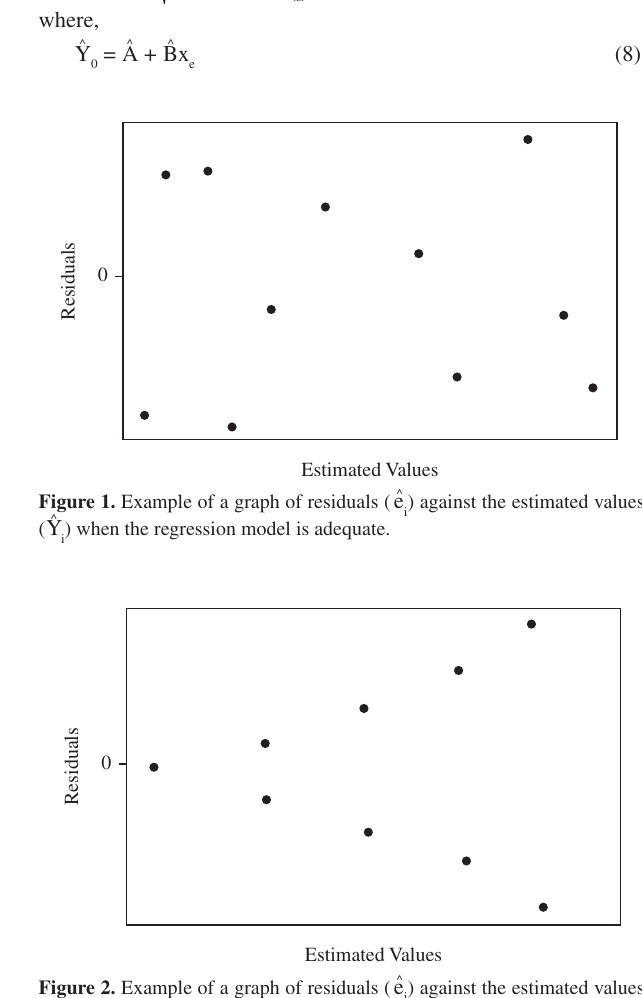
) against the estimated values i